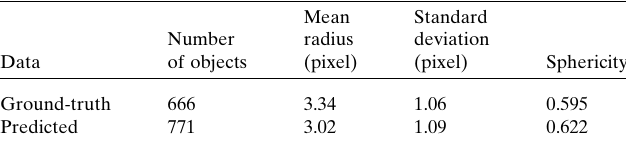
Table 1 Quantitative object information for the ground-truth data and the predicted data for the test set.